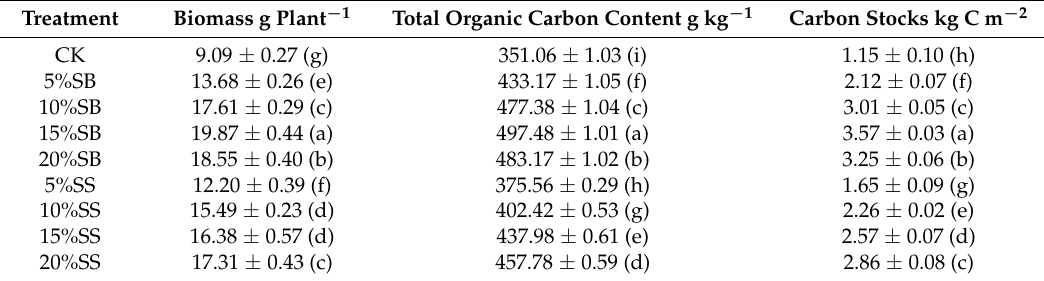
Table 1. Biomass and mean total organic carbon content of green roof plants.